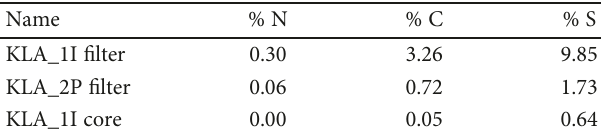
Table 3: CNS concentrations in core material and fi lter residual from the production (2P) site and injection (1I)